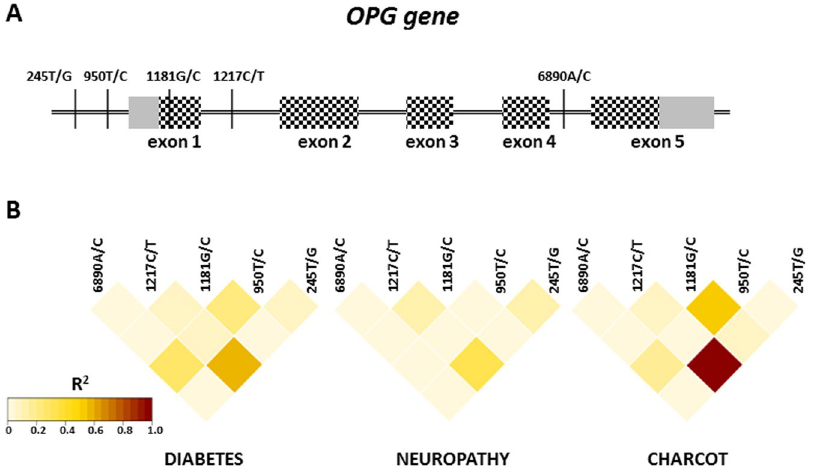
Figure 2. Linkage disequilibrium analysis for selected polymorphisms in the OPG gene. ( A ) Schematic representation of the OPG gene with position of studied polymorphisms. Exons are marked as boxes, with coding sequence marked as chessboard. ( B ) Linkage disequilibrium heat-maps are based on the r 2 value, calculated for each pair. Color intensity corresponds to higher r 2 values, according to the legend in the bottom left corner.